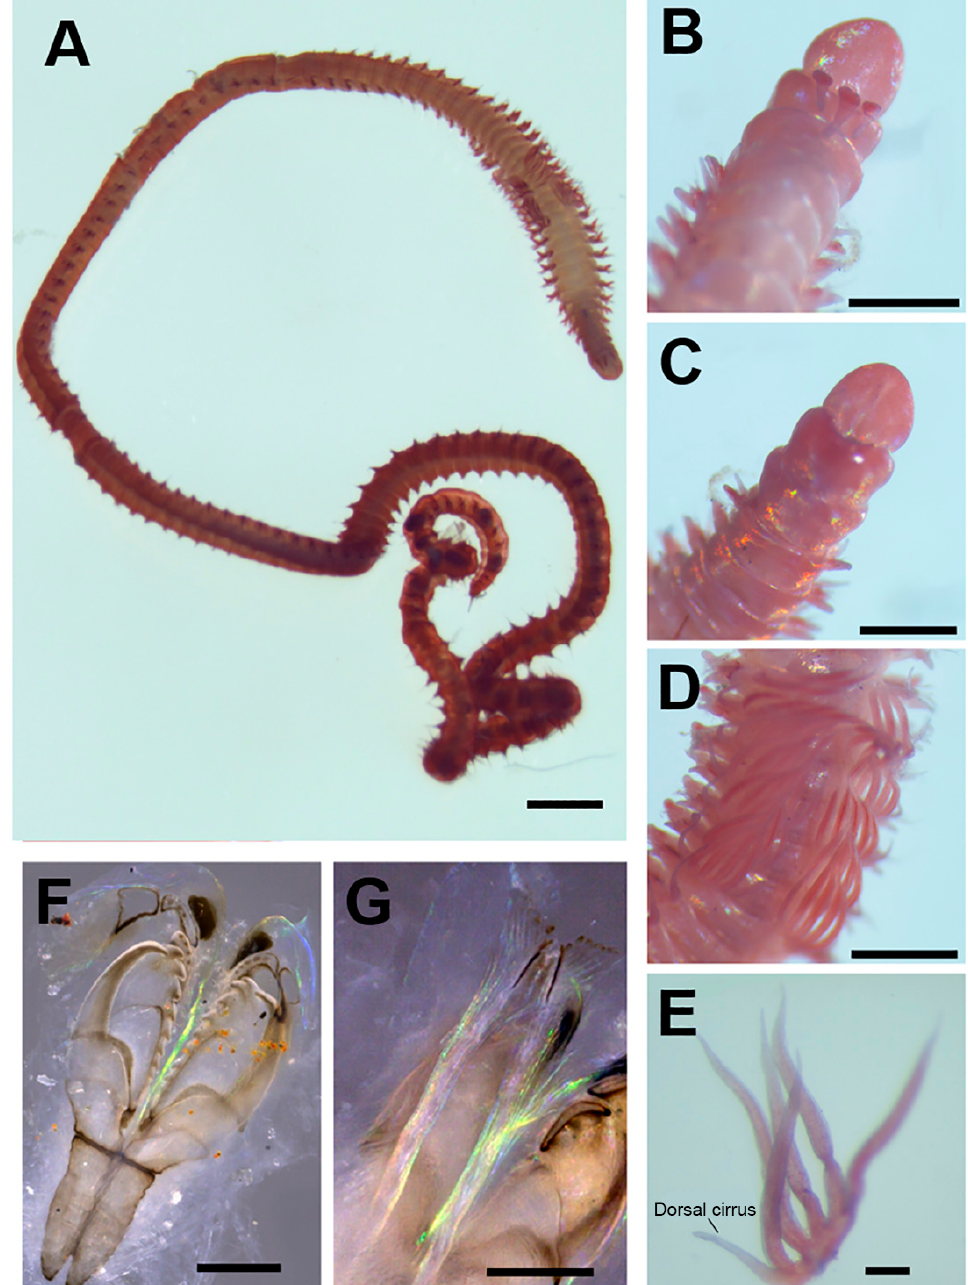
Figure 2. Paucibranchia triantennata sp. Nov: ( A ) holotype, intact specimen; ( B ) prostomium, dorsal view; ( C ) prostomium, ventral view; ( D ) branchiae in chaetigers 12–18; ( E ) branchial filaments of chaetiger 15; ( F ) maxillae; ( G ) mandible. Scale bars: 1 mm ( A ); 500 μ m ( B – D ); 100 μ m ( E – G ). Maxillary apparatus has a maxillary formula = 1 + 1, 8 + 8, 4 + 0, 3 + 5, 1 + 1 (Figure 2F). Maxillary carriers are 1.5 times shorter than MI length. MI is forceps-like. The closing system is approximately six times shorter than the MI length. The ligament between MI and MII is not sclerotized. MII is wide, the teeth are recurved, and the cavity opening is oval, approximately three times shorter than the length of MII. Short MIII has triangular teeth and attachment lamella slightly sclerotized (Figure 2F). The left MIV has a smaller basal tooth, and the right MIV has teeth of similar size. Rectangular MV has a short- rounded tooth. The mandibles and cutting plates are translucent, with approximately seven growth rings (Figure 2G).